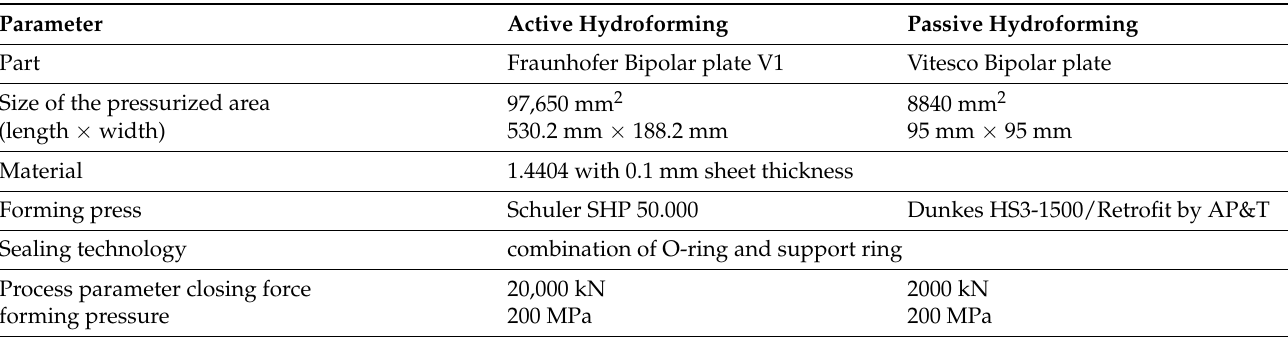
Table 3. Parameters for the comparison of active and passive